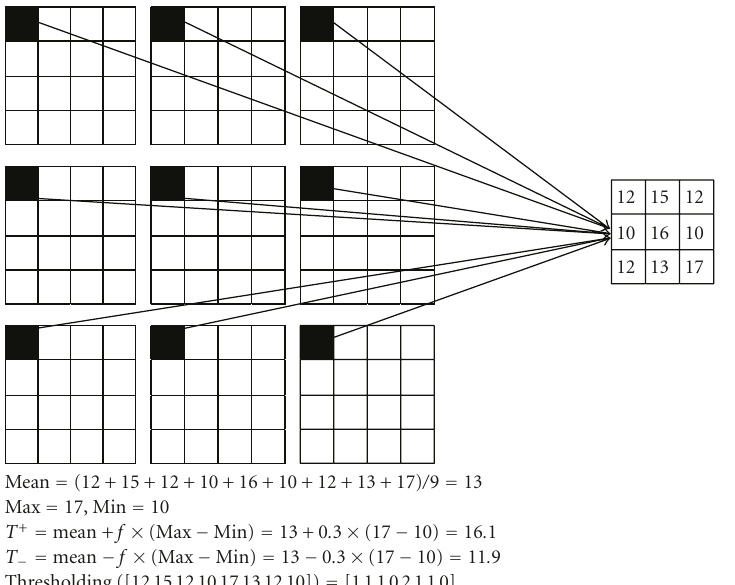
Figure 2: Formation of TFV vector: nine 0th coe ffi cients are extracted from the neighboring 3 × 3 transformed blocks. The corresponding TFV is formed based on this 3 × 3 coe ffi cient matrix.